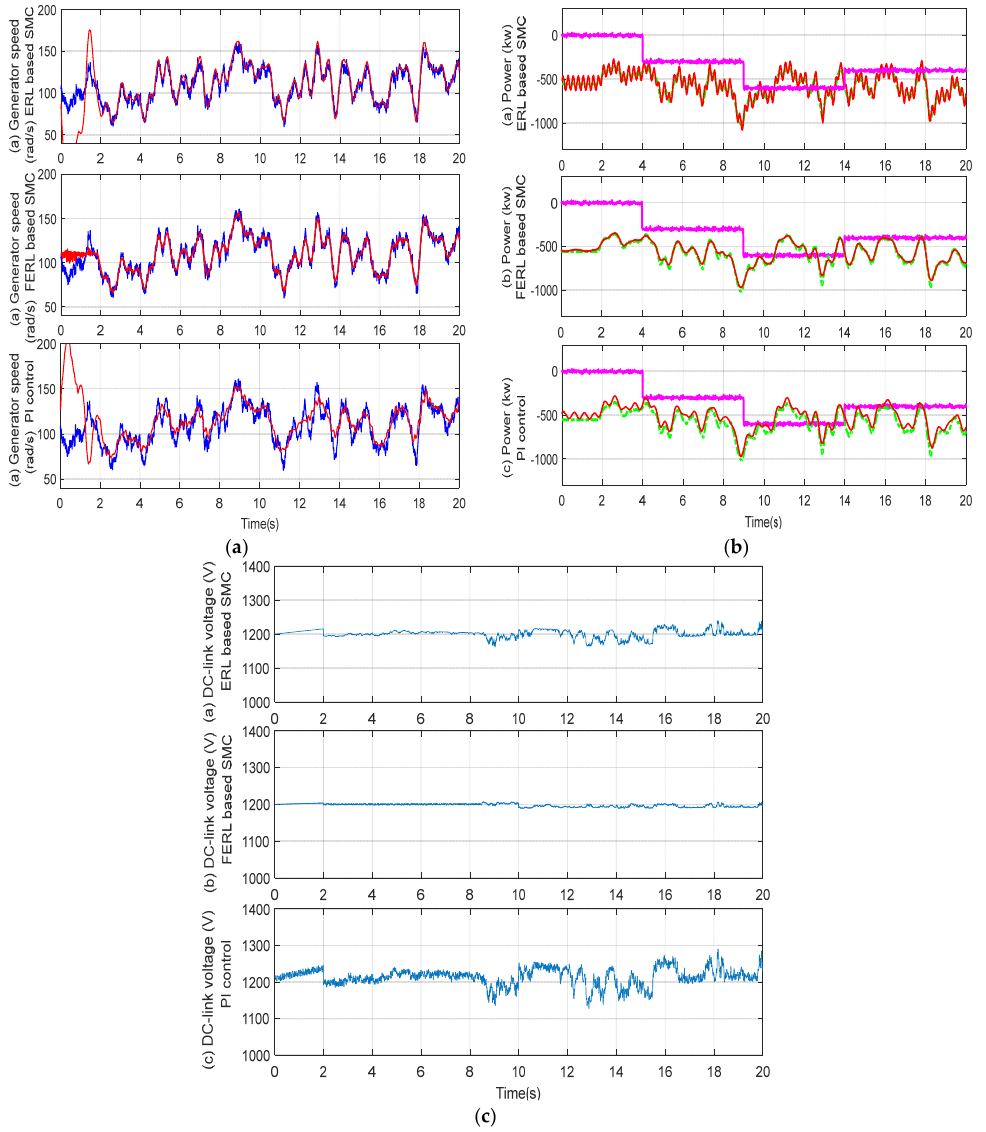
Figure 11. Simulation results under variable wind speed comparing three different approaches: ( a ) generator speed ( b ) active power tracking; ( c ) DC ‐ link voltage.